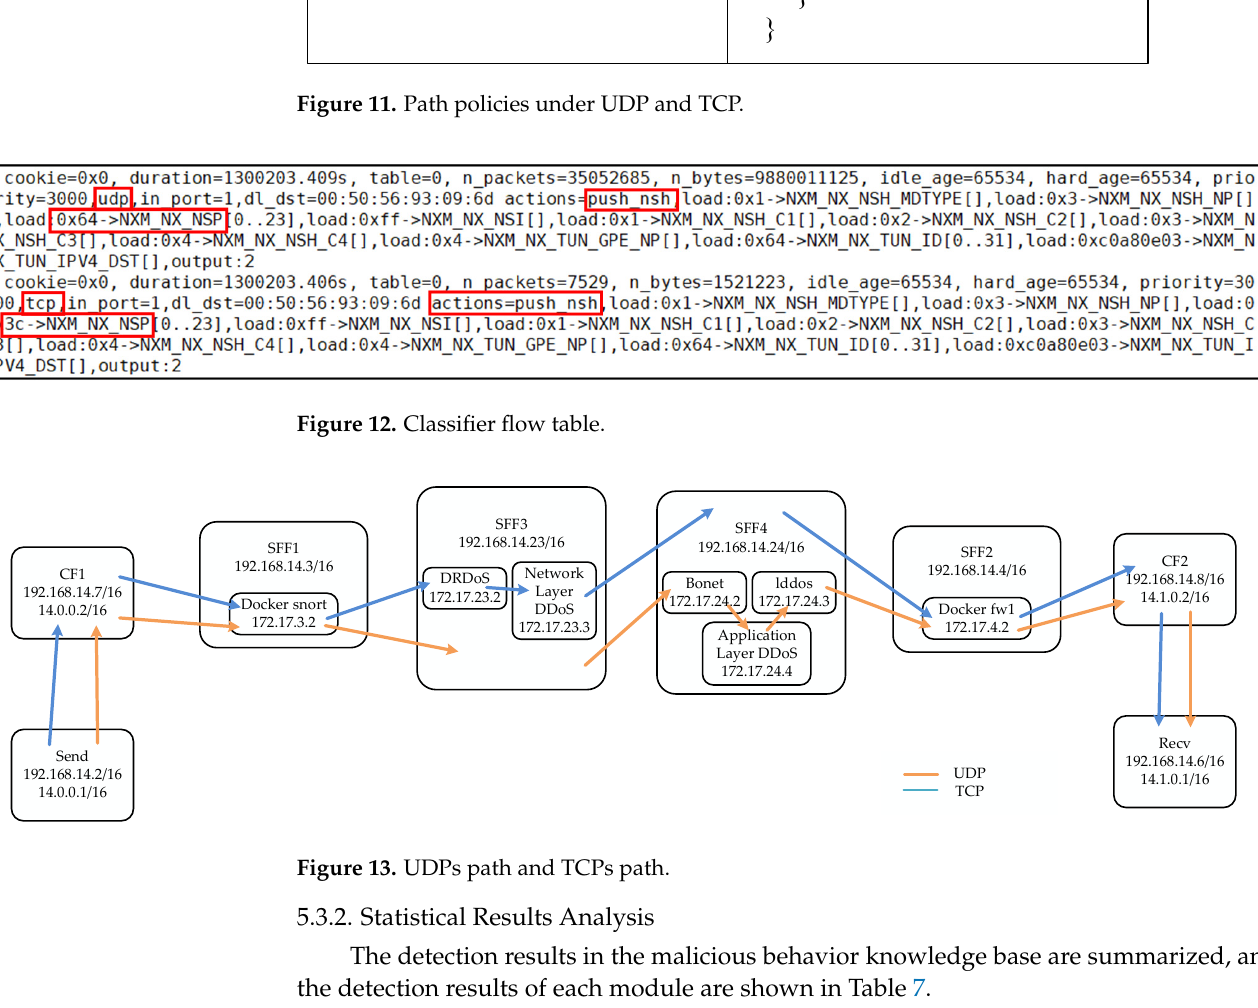
Table 7. The detection results of each module.